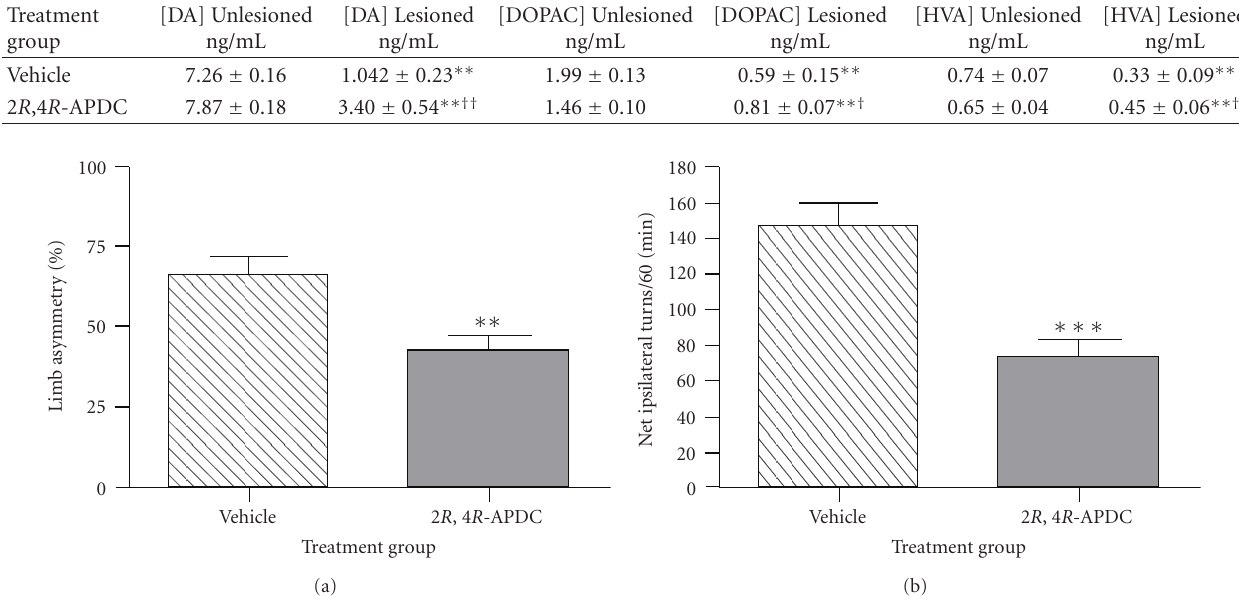
Table 1: Mean striatal concentrations of dopamine (DA), dihydroxyphenylacetic acid (DOPAC), and homovanillic acid (HVA) as measured by HPLC-ECD in the unlesioned and lesioned striata in each treatment group. Data shown are mean ng/mg wet weight tissue ± s.e.m. ∗ P < . 05, ∗∗ P < . 01 unlesioned versus lesioned hemisphere, † P < . 05, †† P < . 01 2 R ,4 R -APDC versus vehicle-treated animals [10]. Drug concentration in nmol (final injection volume 4 μ L).